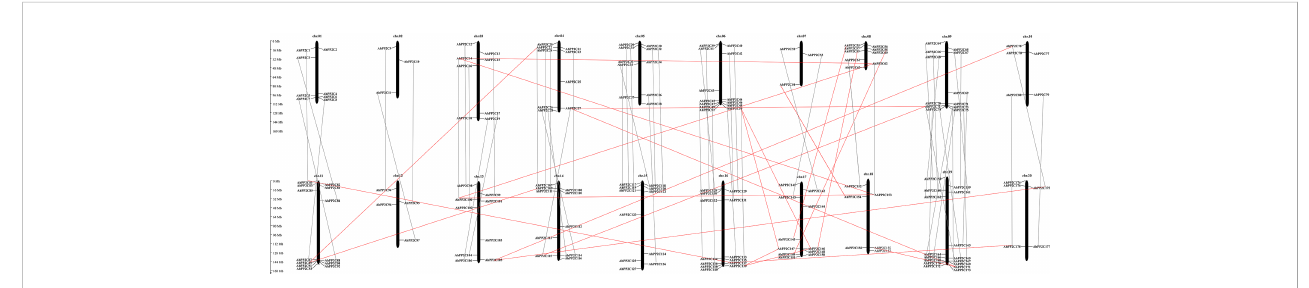
FIGURE 2 Chromosomal distribution of AhPP2C s. Orthologous genes were linked by gray lines. Paralogous genes were linked by red lines.